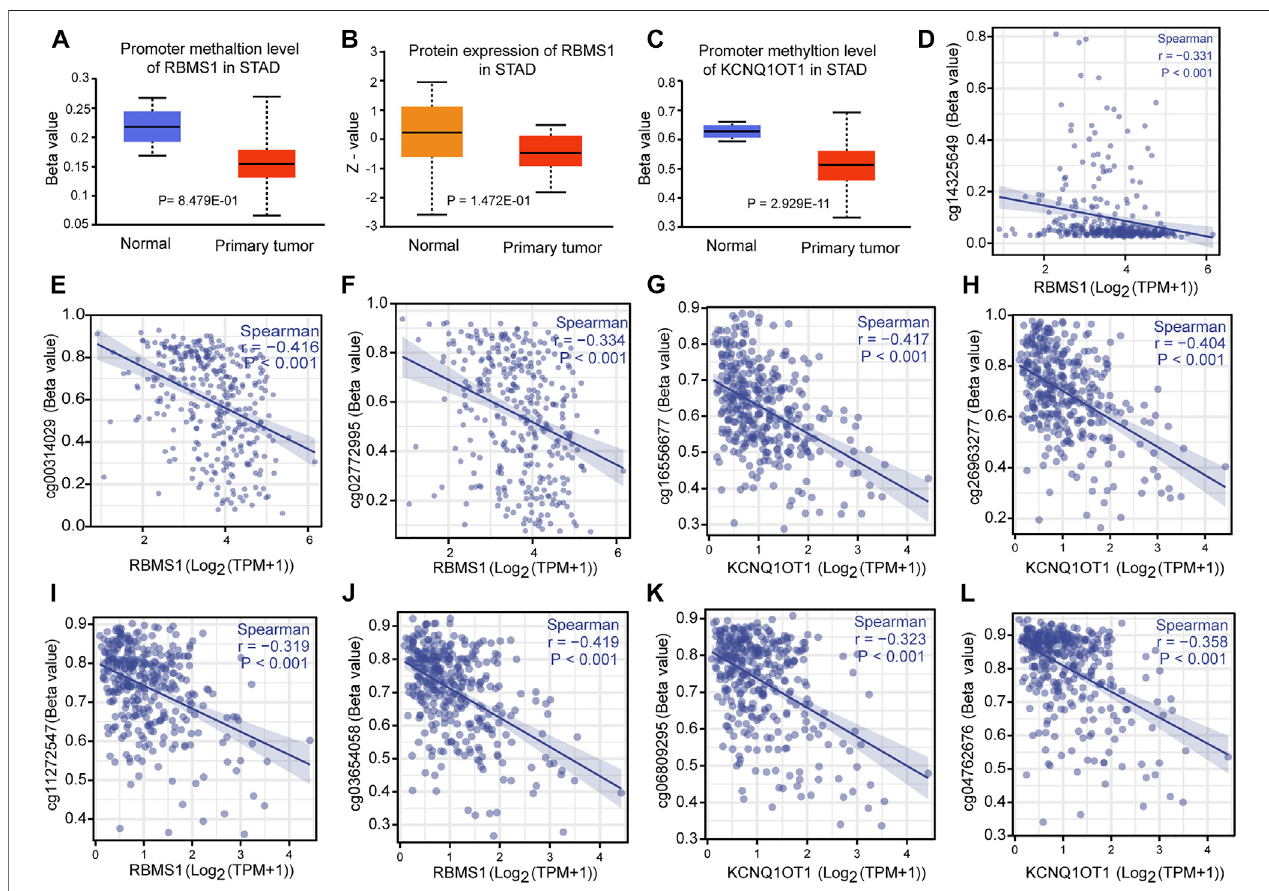
FIGURE 9 | Correlation between methylation and the KCNQ1OT1/RBMS1 axis. (A,B) Methylation levels and protein expression of RBMS1 in GC and normal tissues. (C) Methylation levels of KCNQ1OT1 in GC and normal tissues. (D – L) Correlation between methylation sites and the KCNQ1OT1/RBMS1 axis.